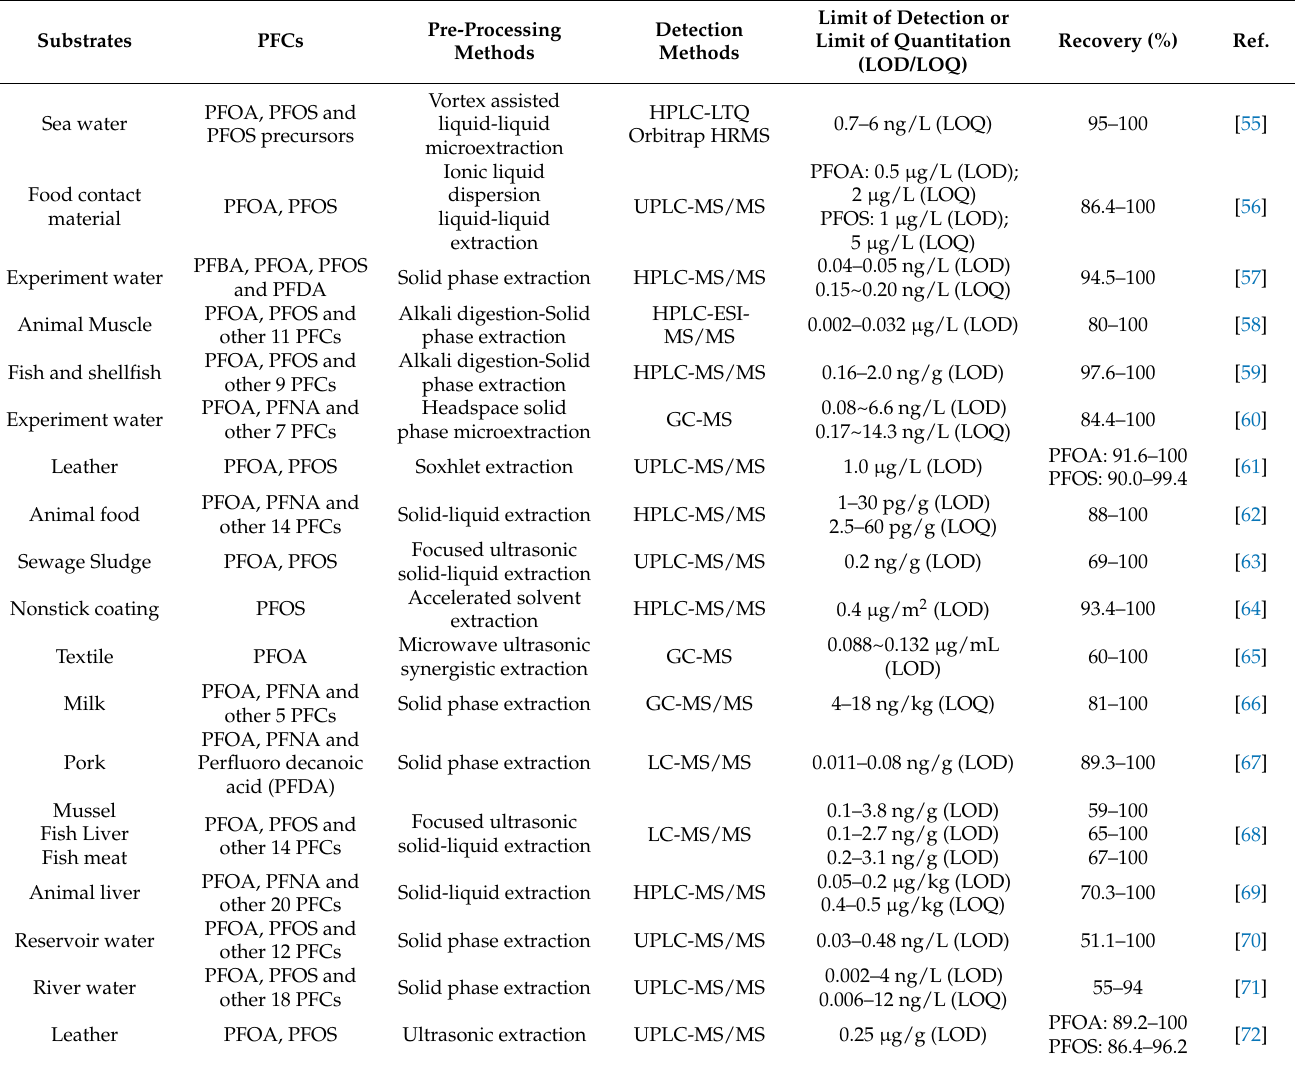
Table 1. Pre-treatment and detection methods for